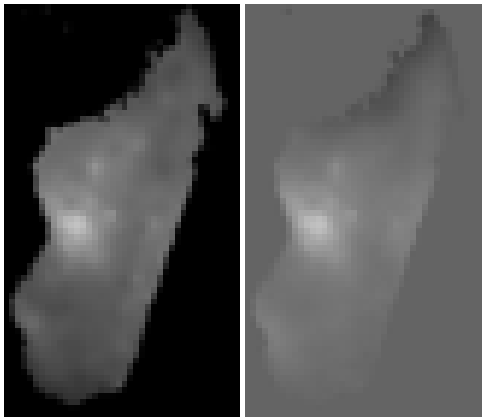
Figure 4. Pre-processed rainfall images (compare first image in Figure 2): raw image ( left ) and de-seasonalized image ( right